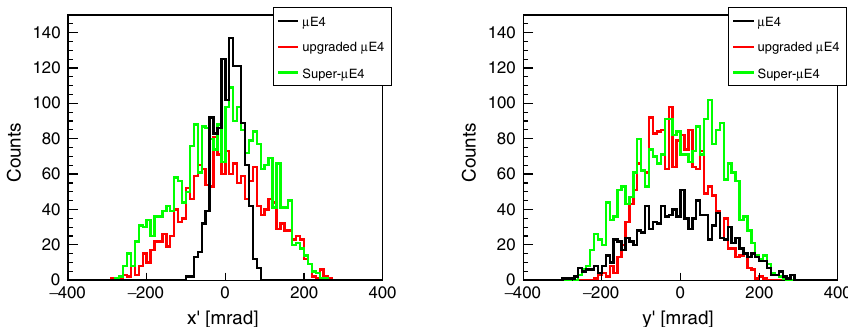
FIG. 25. Comparison of divergences for different beamline settings with the OTE.